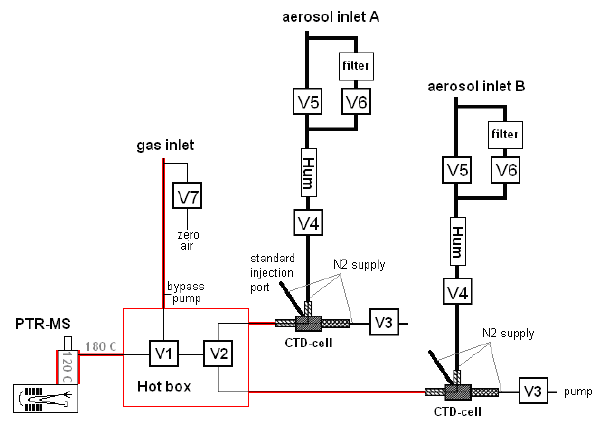
Fig. 1. Schematic drawing of the setup. If not indicated other- wise, all areas marked in red were operated at high temperatures Figure 1. Schematic drawing of the setup. If not indicated otherwise, all areas marked in red of 200 ◦ C. Note that during this campaign the gas inlet was NOT heated outside the were operated at high temperatures of 200 °C. Note that during this campaign the gas inlet was NOT heated outside the building.